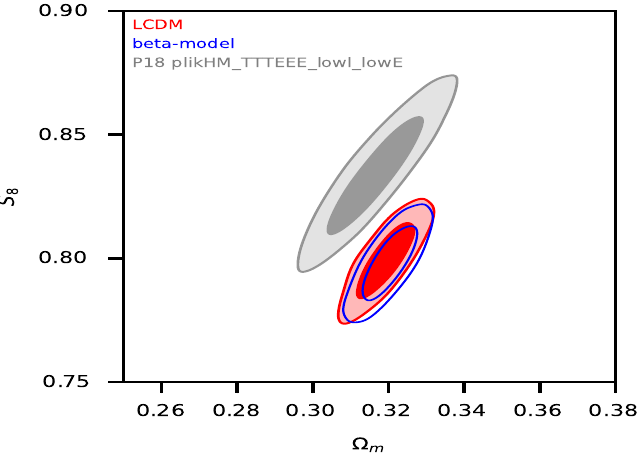
Figure 2. Comparison between the models in the plane ( S 8 − Ω m ) showing contour plots at 68.4% and 95.7% C.L. Blue and red colors indicate the β -model and Λ CDM, respectively, in contrast, in gray, with Planck 2018 plik.TTTEEE + low EE + low TT baseline chains. (For interpretation of the references to color in this figure legend, the reader is referred to the web version of this